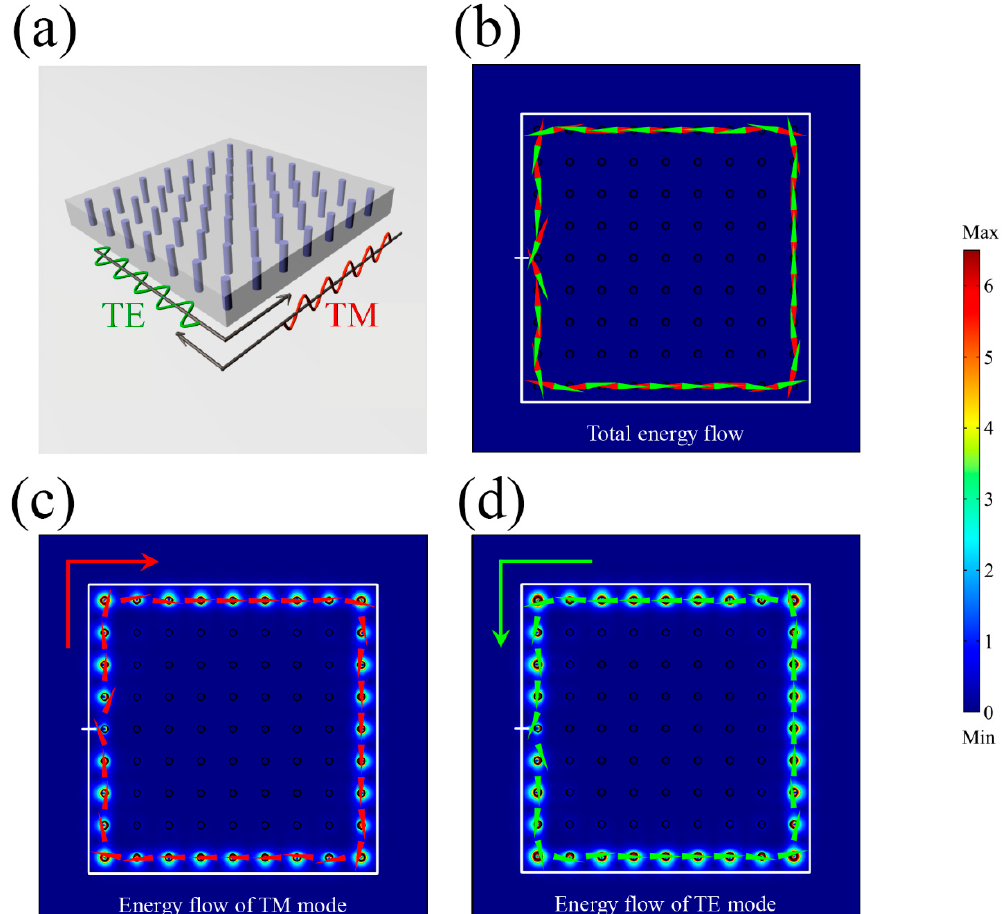
Figure 2. Energy flow of a “ring-shaped” structure. ( a ) A schematic of the total energy flow in a ring-shaped PTI. ( b ) The net zero energy flow for the TE and TM modes combined. ( c ) The clockwise propagating energy flow of the TM mode. ( d ) The anti-clockwise propagating energy flow of the TE mode. The white bar represents the excitation source. The color on site represents the amplitude of the energy flow. Red (green) arrows represent the flow direction of the TM (TE) mode.